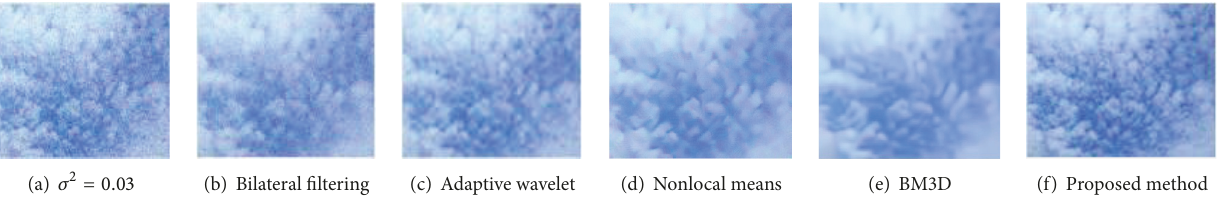
Figure 12: Image 10: comparison of various experimental results under noise variance 𝜎 2 = 0.03